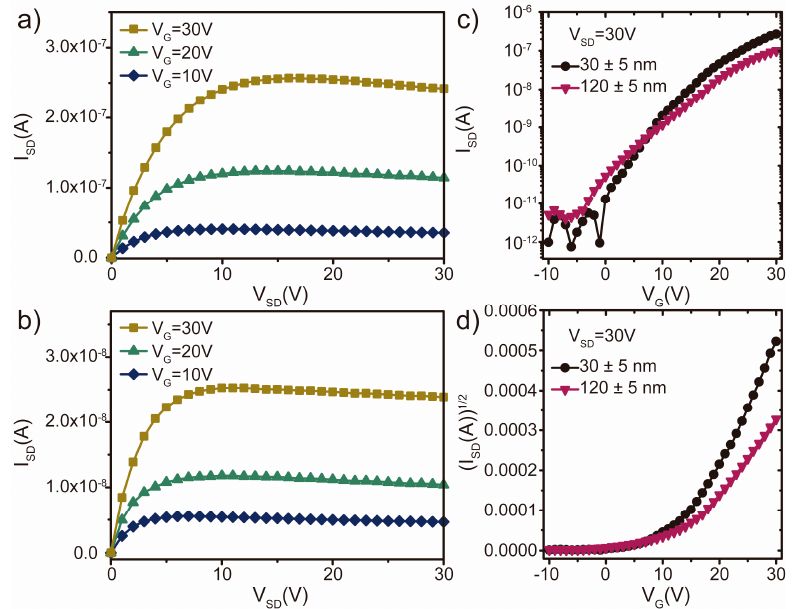
Figure 5. Output characteristics of TFTs with a patterned InGaZnO channel layer thickness of 30 nm ( a ) and 120 nm ( b ). ( c , d ) Transfer characteristics of TFTs with different InGaZnO channel layer thicknesses. The channel length and width of the above TFTs are about 60 and 300 µm.